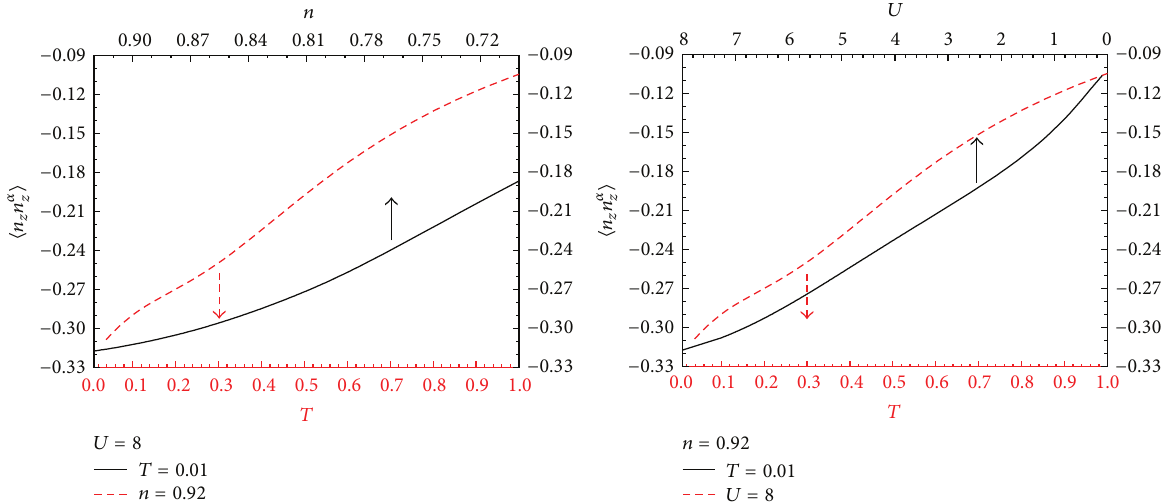
Figure 11: (Color online) The spin-spin correlation function ⟨𝑛 𝑧 𝑛 𝛼 𝑧 ⟩ as a function of filling 𝑛 , temperature 𝑇 , and on-site Coulomb repulsion 𝑈 in the ranges 0.7 < 𝑛 < 0.92 , 0.01 < 𝑇 < 1 , and 0.1 < 𝑈 < 8 .